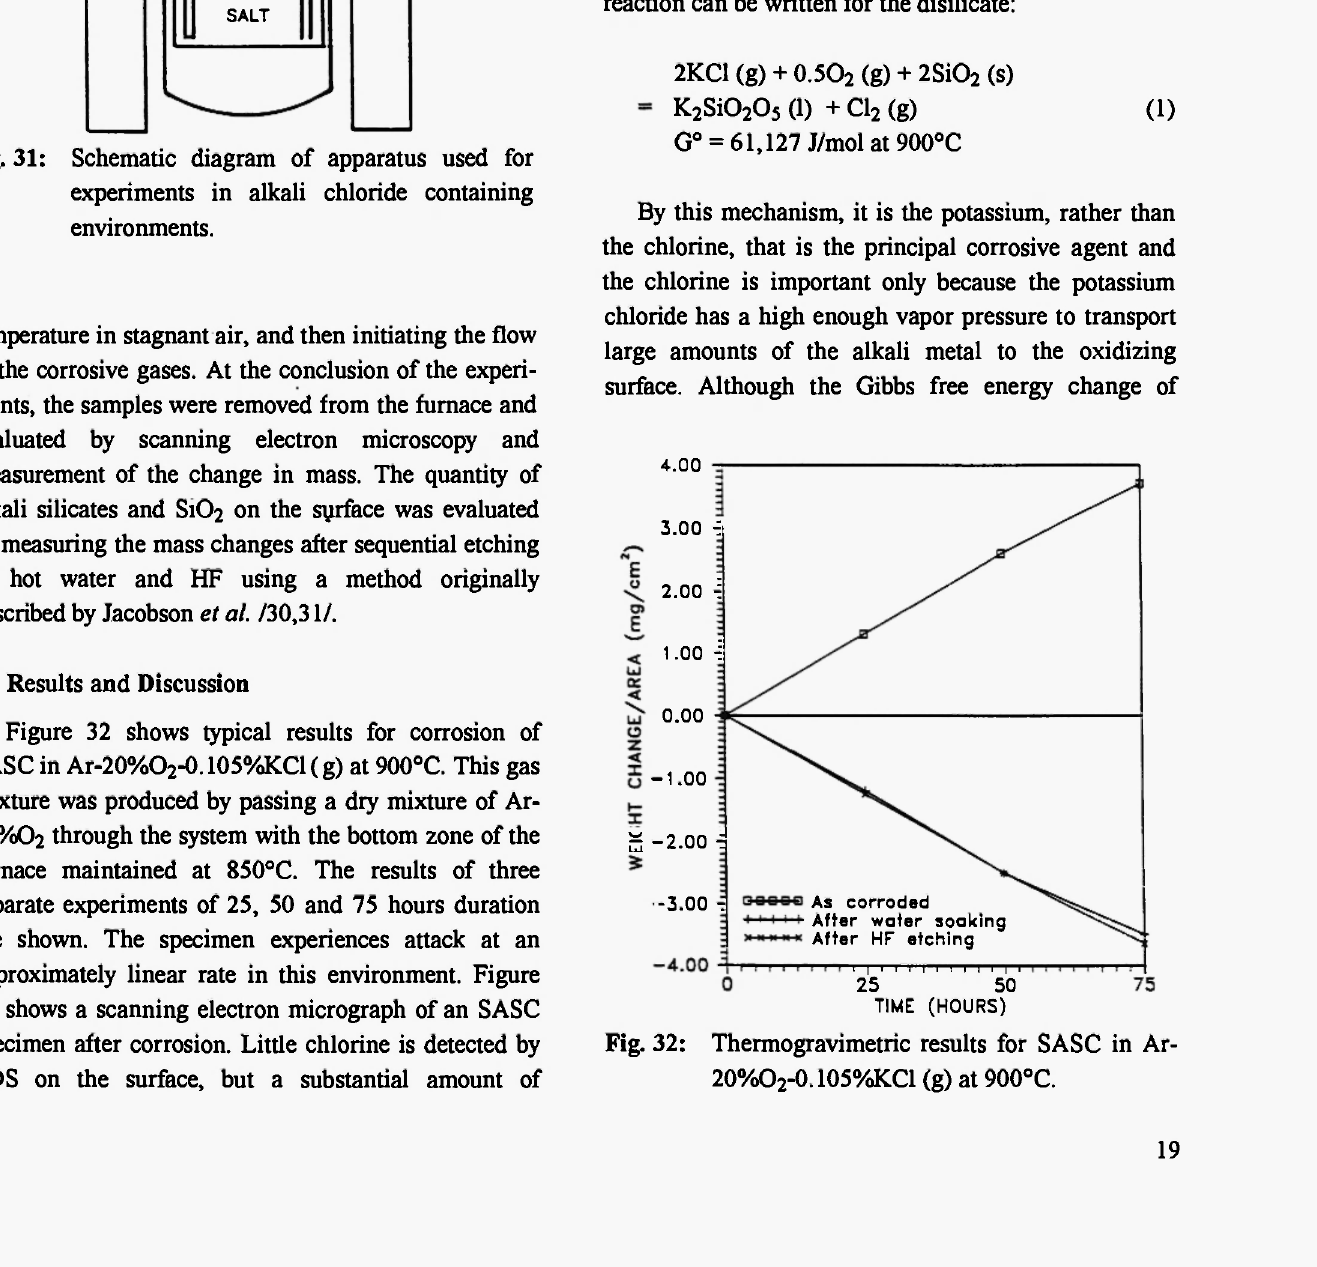
Fig. 32: Thermogravimetric results for SASC in Ar- 20%0 2 -0.105%KC1 (g) at